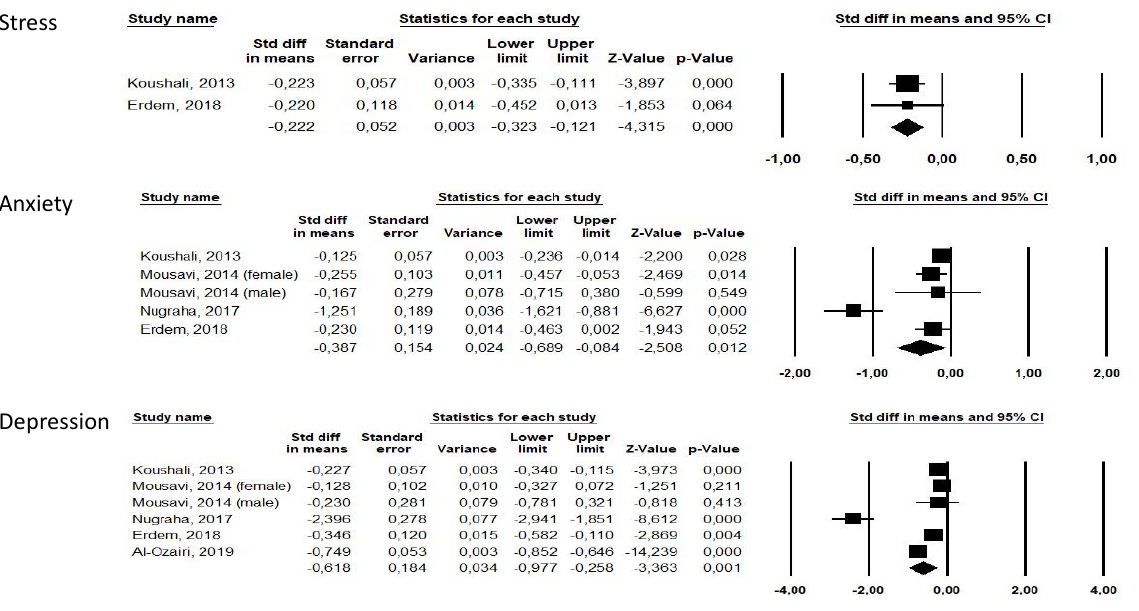
Figure 2. Forests plots of Ramadan studies for stress, anxiety and depression. Overall, Ramadan was associated with improved stress (b = −0.222 [−0.323;−0.121], p < 0.0001, I2 = 0), improved anxiety (b = −0.387 [−0.689;−0.084], p = 0.012, I2 = 87.79) and i mproved depression (b = −0.618 [−0.977 ;−0.258], p = 0.001, I2 = 95.32).